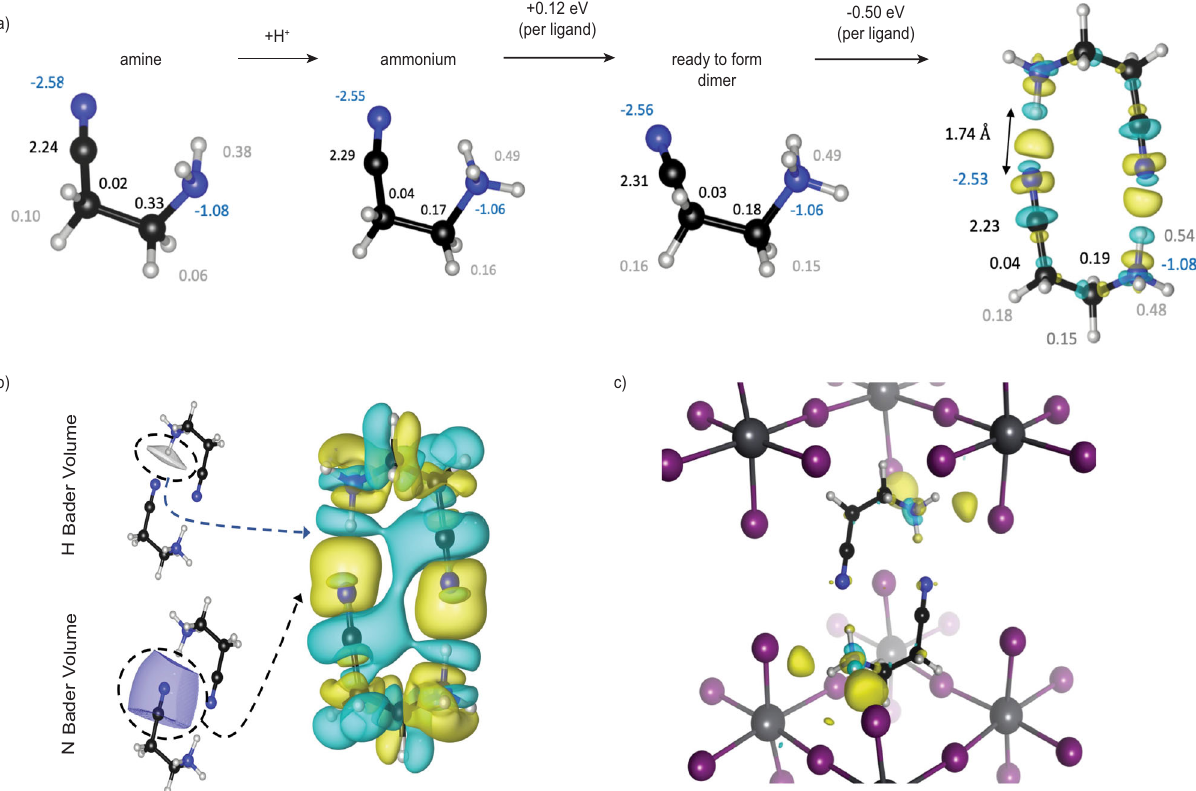
Fig. 2 Organic interactions, and their in fl uence on the inorganic backbone. a Protonation of an amine to form ammonium, mechanical deformation to create a dimer-ready ligand, and dimer formation. Numbers indicate atomic Bader charges. The electron-density difference (EDD) plot show changes in electron density upon dimer formation from two monomers. The rendered yellow and cyan regions correspond to electron accumulation and depletion. Color code: nitrogen (blue), carbon (black), hydrogen (white), lead (gray), and iodine (purple); b electron accumulation (bond) between two ligands, associated with a cyclic dipole formation around the ring, shifting electrons to electrophilic regions close to the proton-like hydrogens. EDD isosurfaces correspond to smaller charge transfers, relative to ( a , c ), to better portray dipole formation. Bader volumes indicate charge sharing (covalency) and a small charge transfer from the nitrogen on one ligand to the hydrogen on the other; c formation of strong hydrogen bonds between the dimer and the axial iodides of the inorganic backbone. We observe no strong interactions between the ammonium group and an equatorial